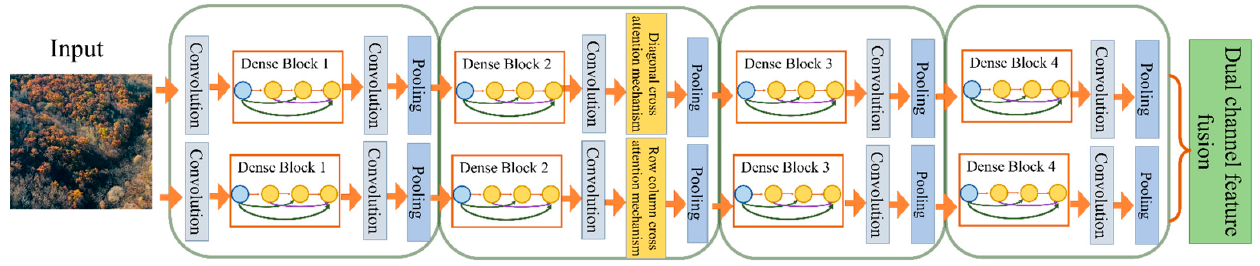
Figure 5. Structure of the MDCN.